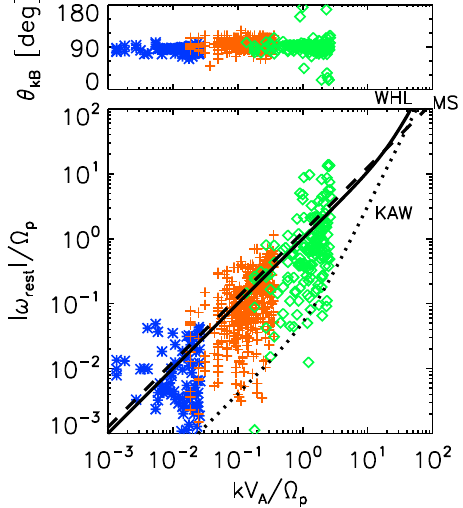
Figure 113: Top: Angles between the wave vectors and the mean magnetic field as a function of the wave number. Bottom: Frequency-wave number diagram of the identified waves in the plasma rest frame. Magnetosonic (MS), whistler (WHL), and kinetic Alfv´en waves (KAW)dispersion relations are represented by dashed, straight, and dotted lines, respectively. Image reproduced by permission from Narita et al. (2011a), copyright by